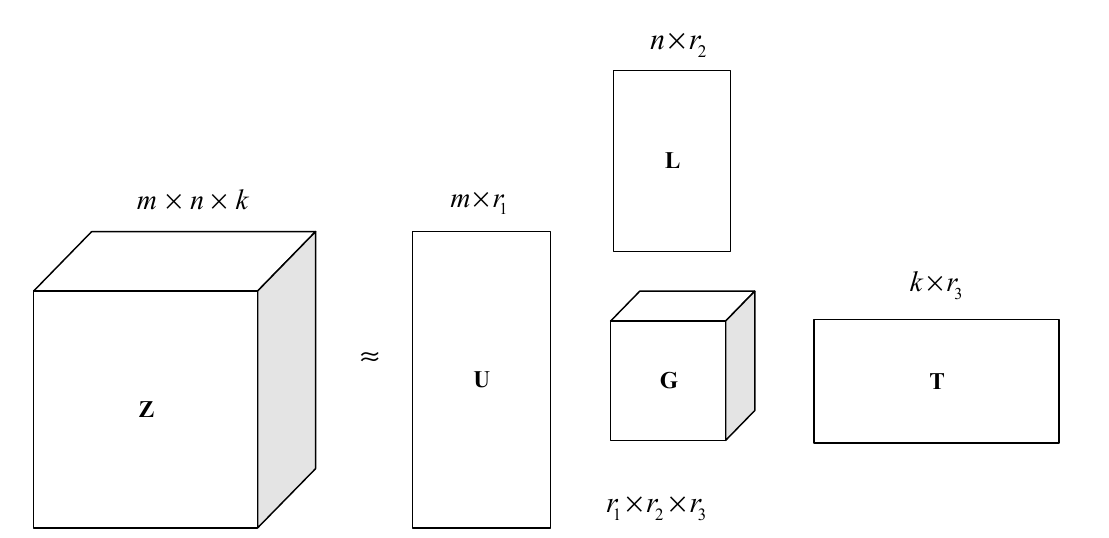
Figure 5. Tucker factorization form of a third-order tensor.